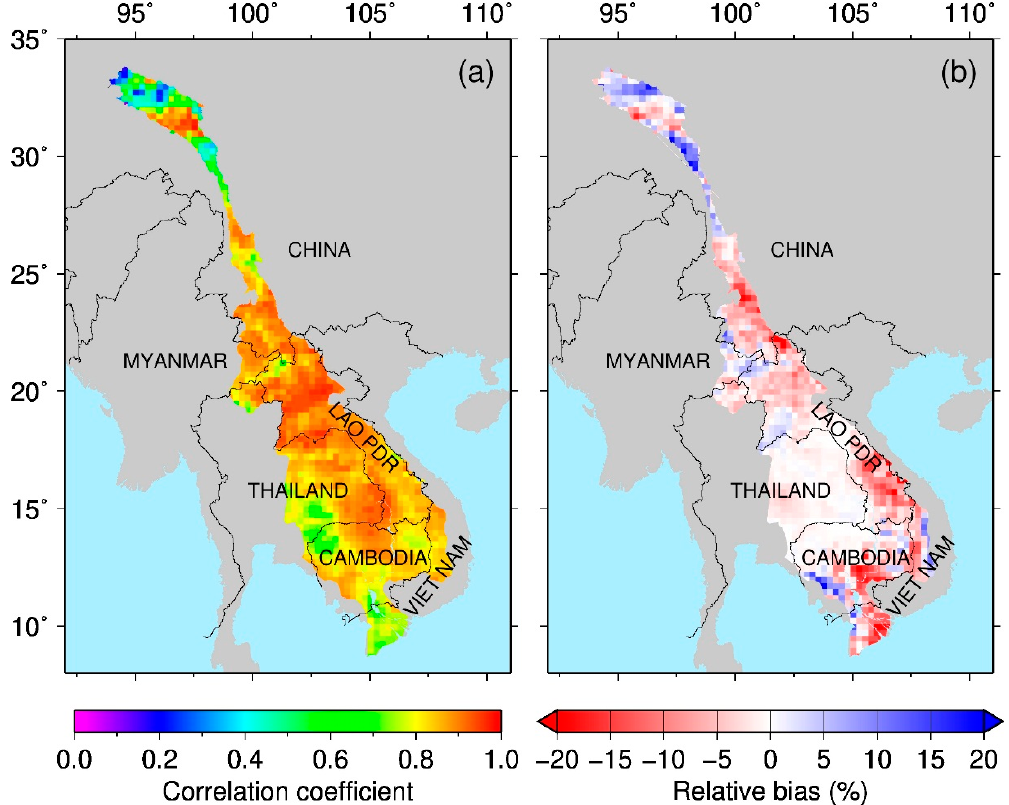
Figure 9. Correlation coefficient ( R ) ( a ) and mean relative bias (%) ( b ) of SM estimates between the correctRT-VIC and PGF-VIC over the 10-year (2001–2010) overlapping period.